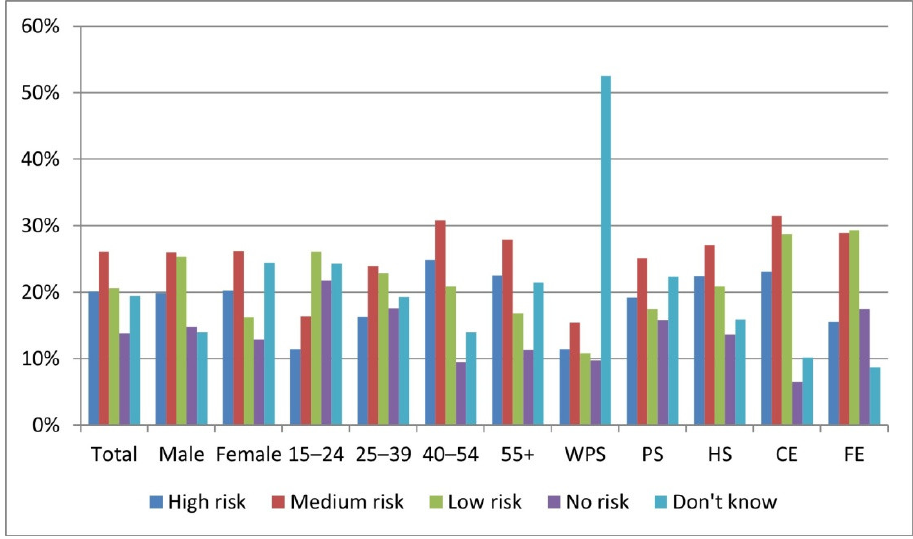
Figure 8. Perception of risk from the NPP Krško and the NPP Paks.